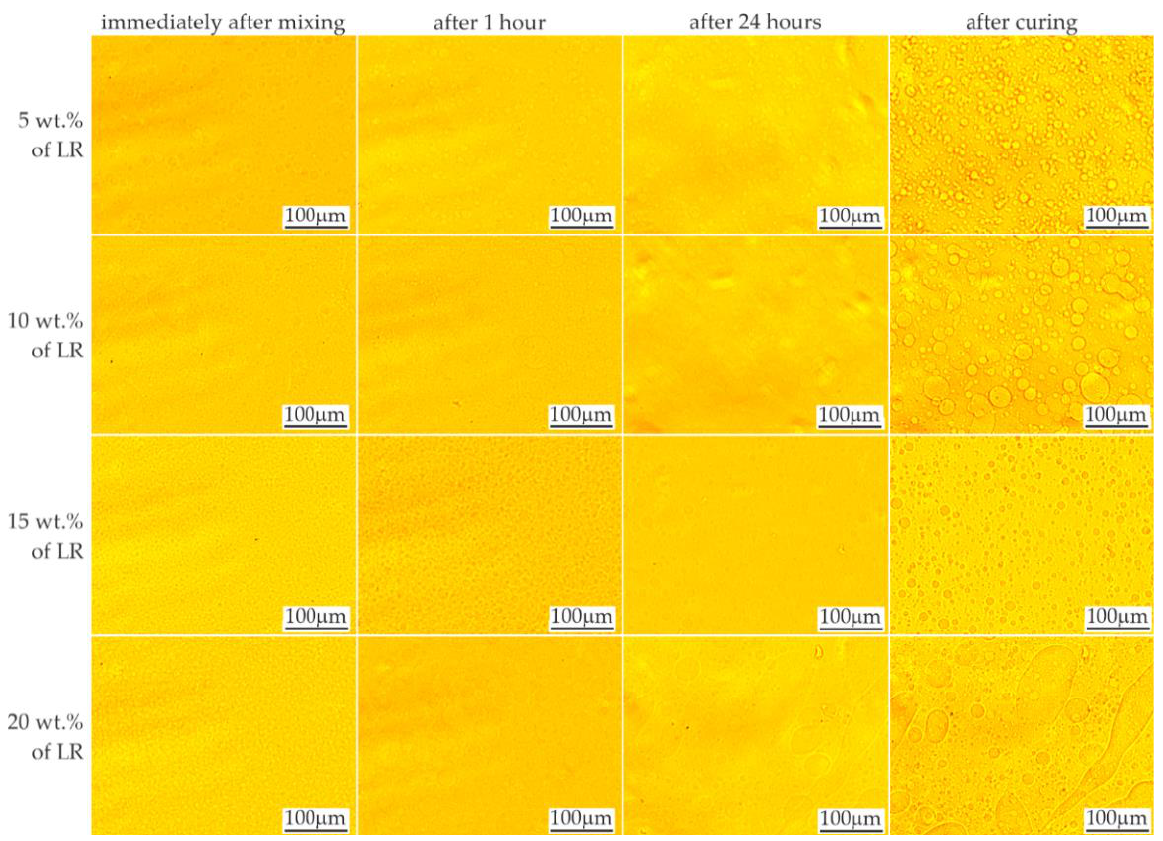
Figure 4. LOM images showing time stability of resin C mixed with liquid rubber.